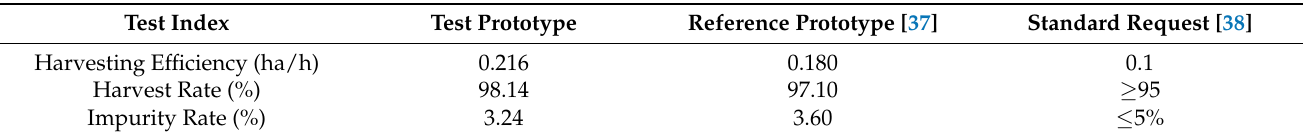
Table 7. Comparison of test